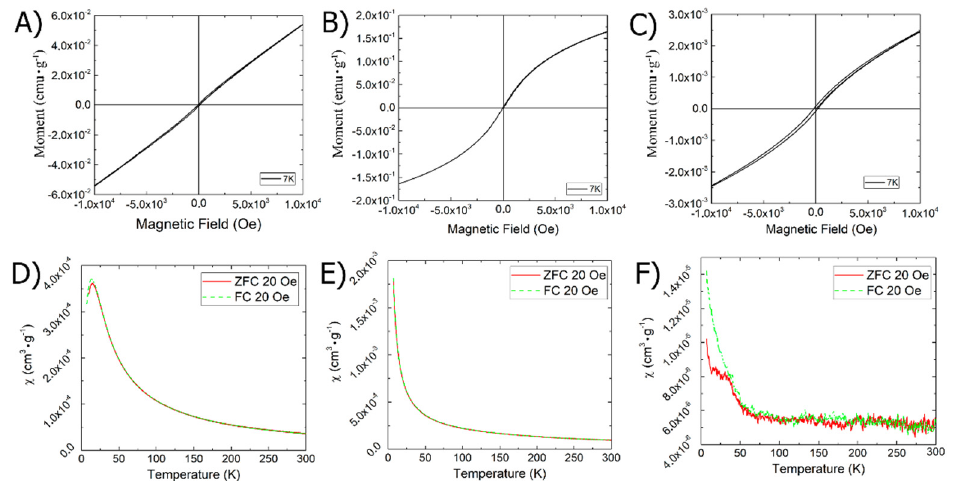
Figure 7. Magnetic hysteresis: ( A ) ChemRed-NP, ( B ) US/TermRed-NP, ( C ) US-NP; FC/ZFC curve: ( D ) ChemRed-NP; ( E ) US/TermRed-NP; ( F ) US-NP.